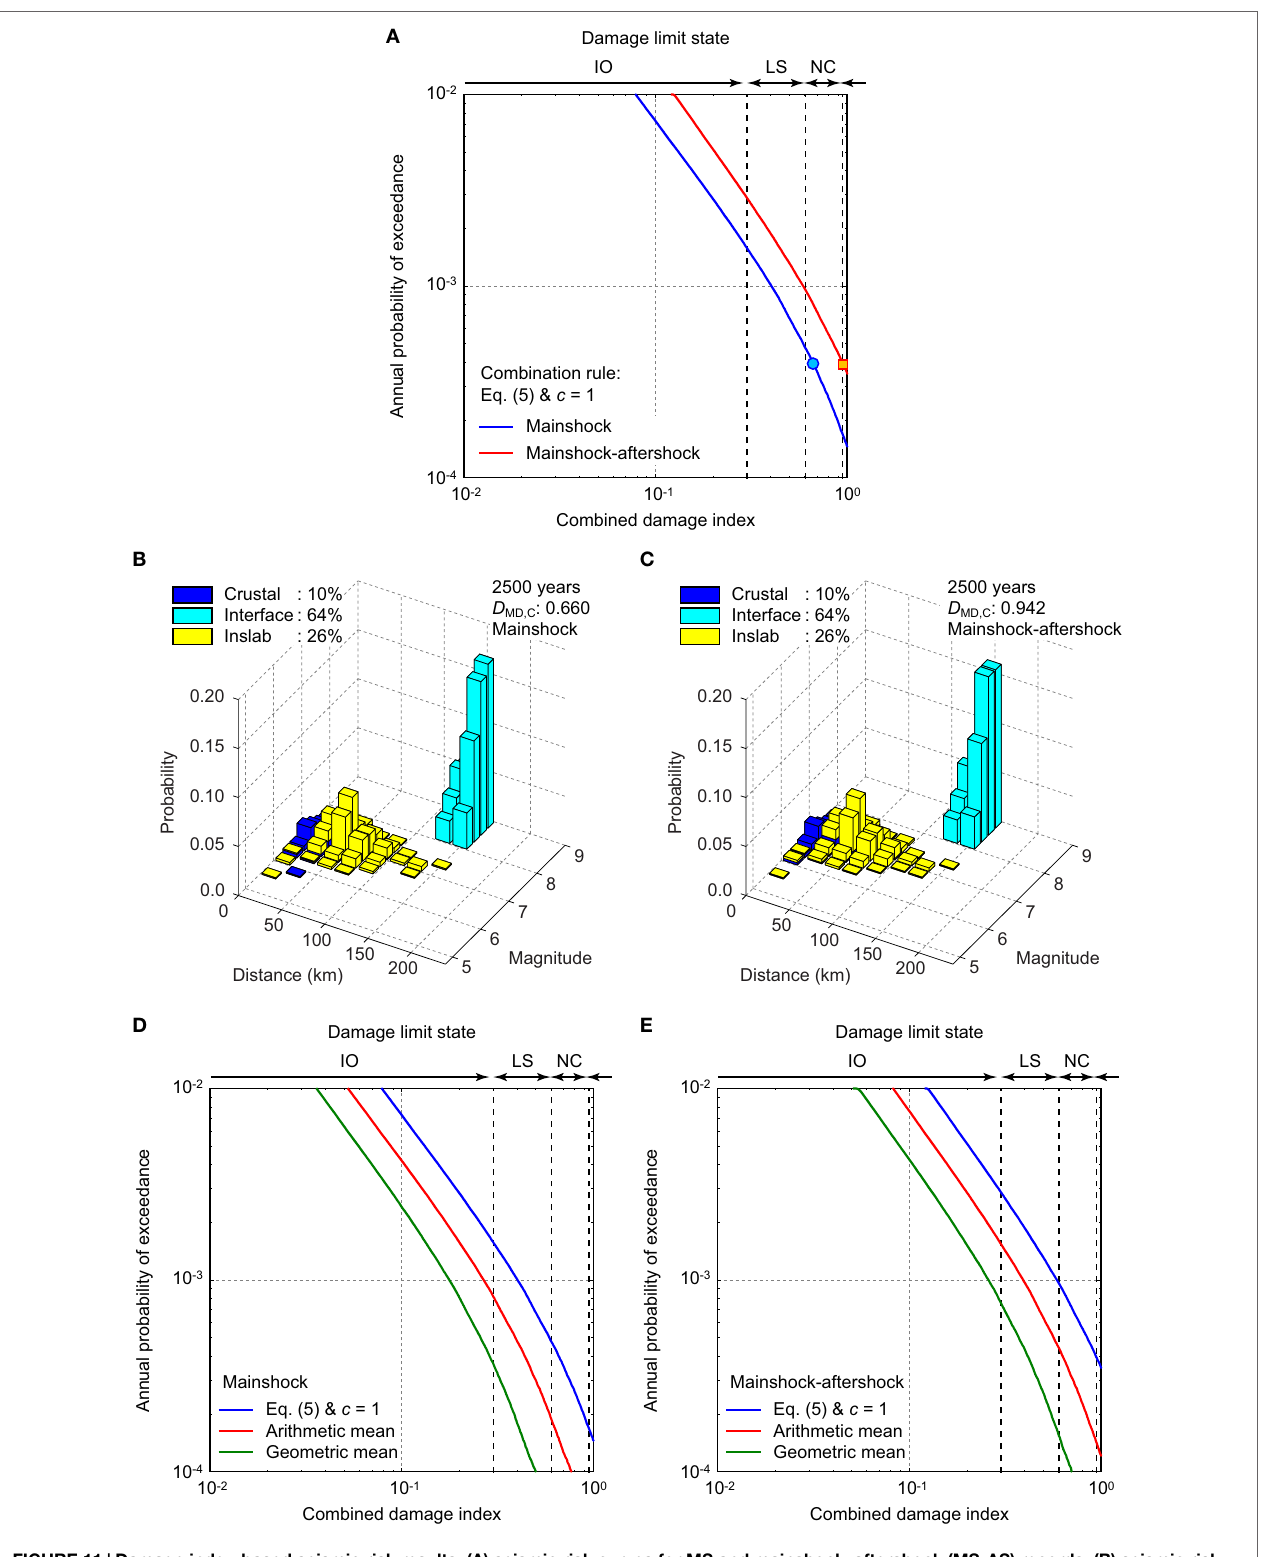
FIGURE 11 | Damage index-based seismic risk results: (A) seismic risk curves for MS and mainshock–aftershock (MS-AS) records, (B) seismic risk disaggregation for MS records, and (C) seismic risk disaggregation for MS-AS records . Comparison of seismic risk curves based on three different combination rules for defining the combined damage index: (D) MS records and (E) MS-AS records.